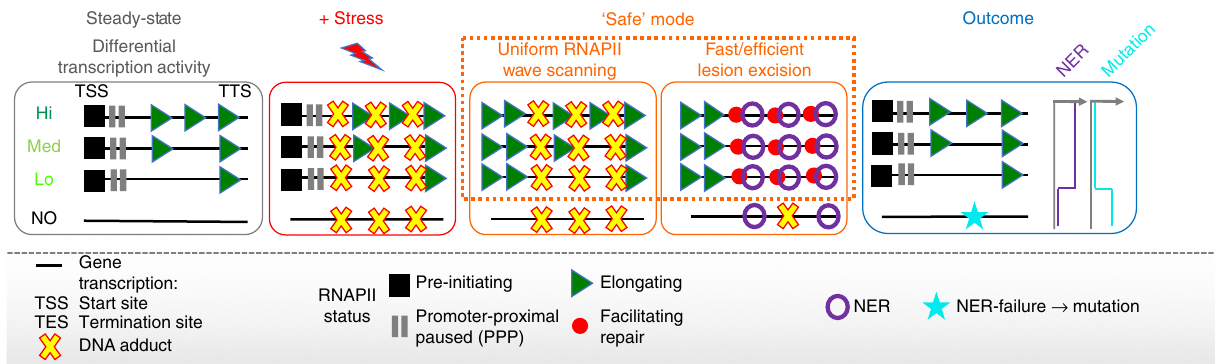
Fig. 7 Model describing the proposed ‘ safe ’ mode of elongation. Upon genotoxic stress, steady-state nascent transcription levels of virtually all expressed genes are adjusted via a transient and uniform de novo wave-release of scanning RNAPII (green triangles) from PPP. This mechanism maximises both speed and probability of the sensing (red dots) and removal (purple rings) of NER-dependent DNA lesions (crosses) throughout the whole transcribed genome. In turn, environmentally exposed genomes are characterised by low and uniform mutation landscape across all active genes in both strands, which sharply contrasts the mutation rates observed in constitutively non-expressed genes. In case NER fails or is not recruited ef fi ciently during stress recovery, unrepaired lesions can provoke error-prone DNA synthesis and result in mutations (turquoise star)